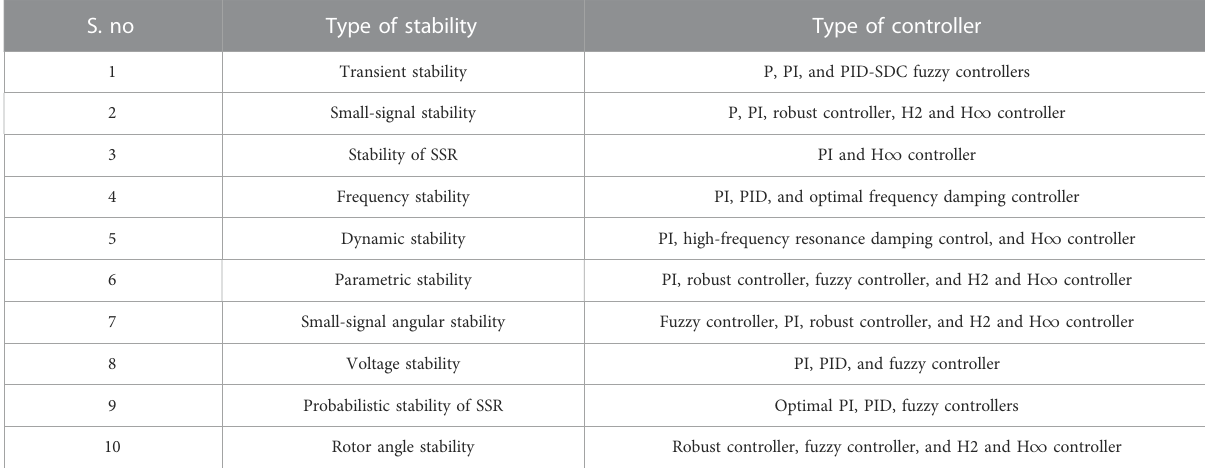
slime mould optimization algorithm improves the